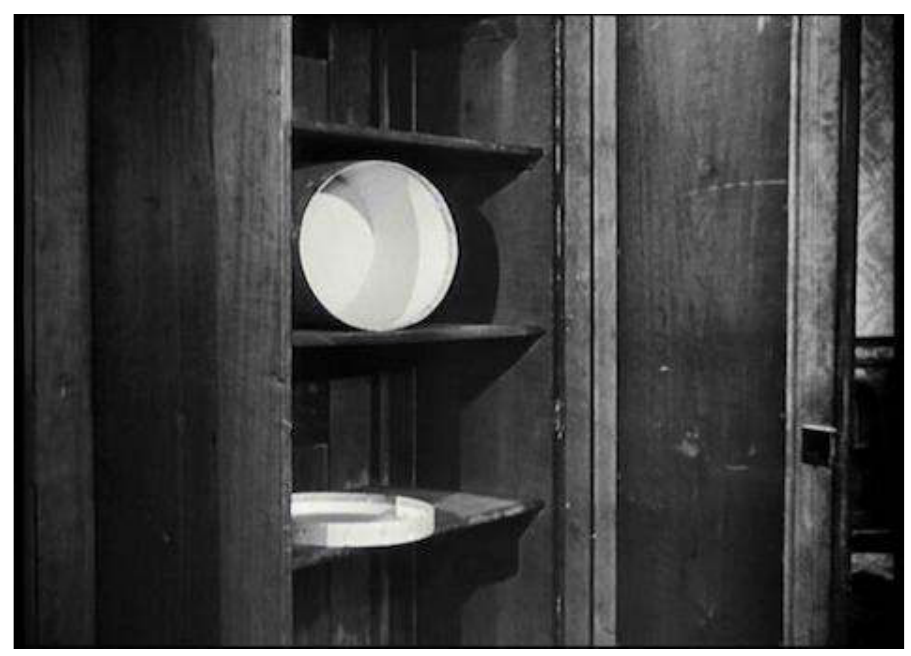
Figure 25: The empty hat box in Silver